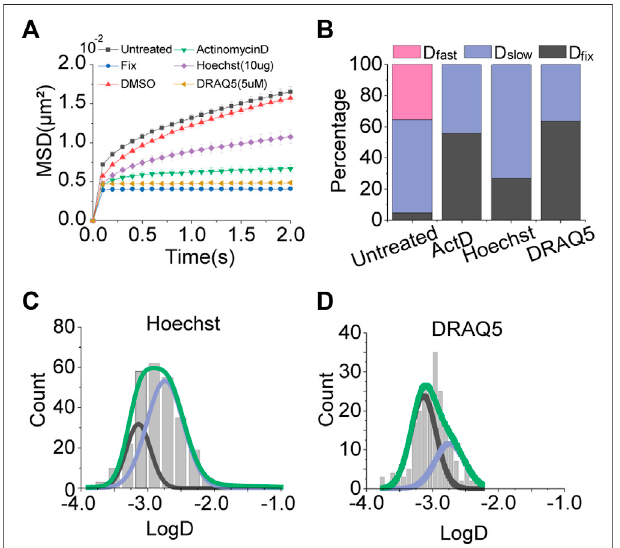
FIGURE 3 | Effects of DNA intercalators. (A) Averaged MSD-t plots for each time interval is normally cultured cells and DNA intercalator treated cells. (Hoechst, N = 20 cells, n = 293 trajectories; DRAQ5, N = 20 cells, n = 262 trajectories) (B) Percentages of diffusion constant components from multimodalGaussian fi ttingsforeachcondition. (C,D) Distributionsofdiffusion constants for individual trajectories in cells treated with Hoechst and DRAQ5, respectively. Green lines represent fi tting with triple Gaussian peaks for the entire distribution. Blue and black lines represent single Gaussian portions for slow and fi xed diffusions, respectively.